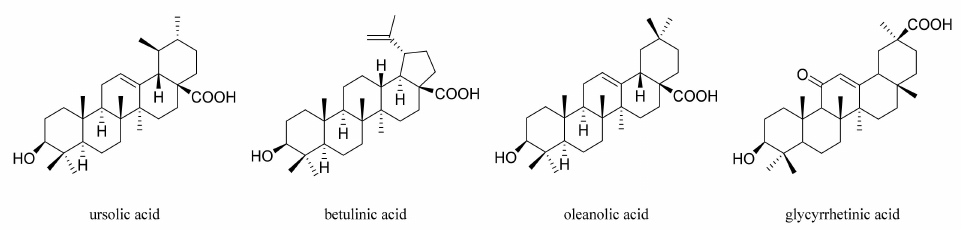
Figure 1. Chemical structures of four parent pentacyclic